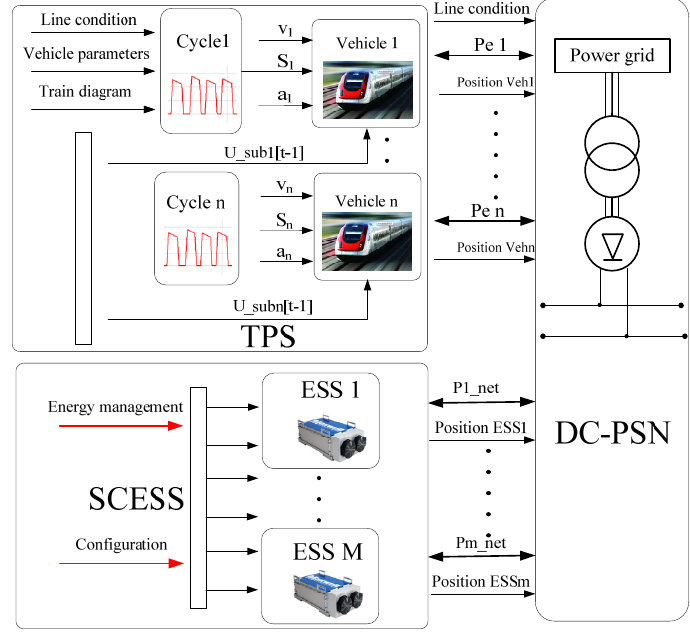
Figure 5. Simulation platform of metro system for power flow